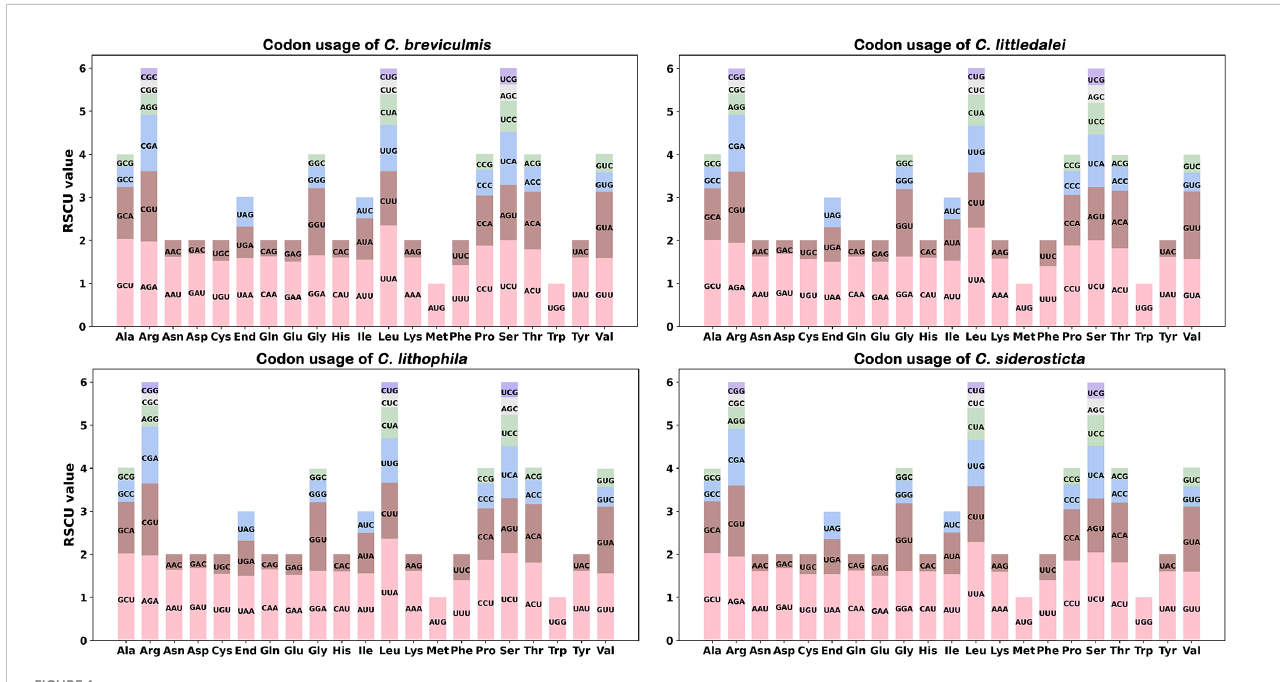
FIGURE 1 Analysis of codon preferences in the chloroplast genomes of four Carex